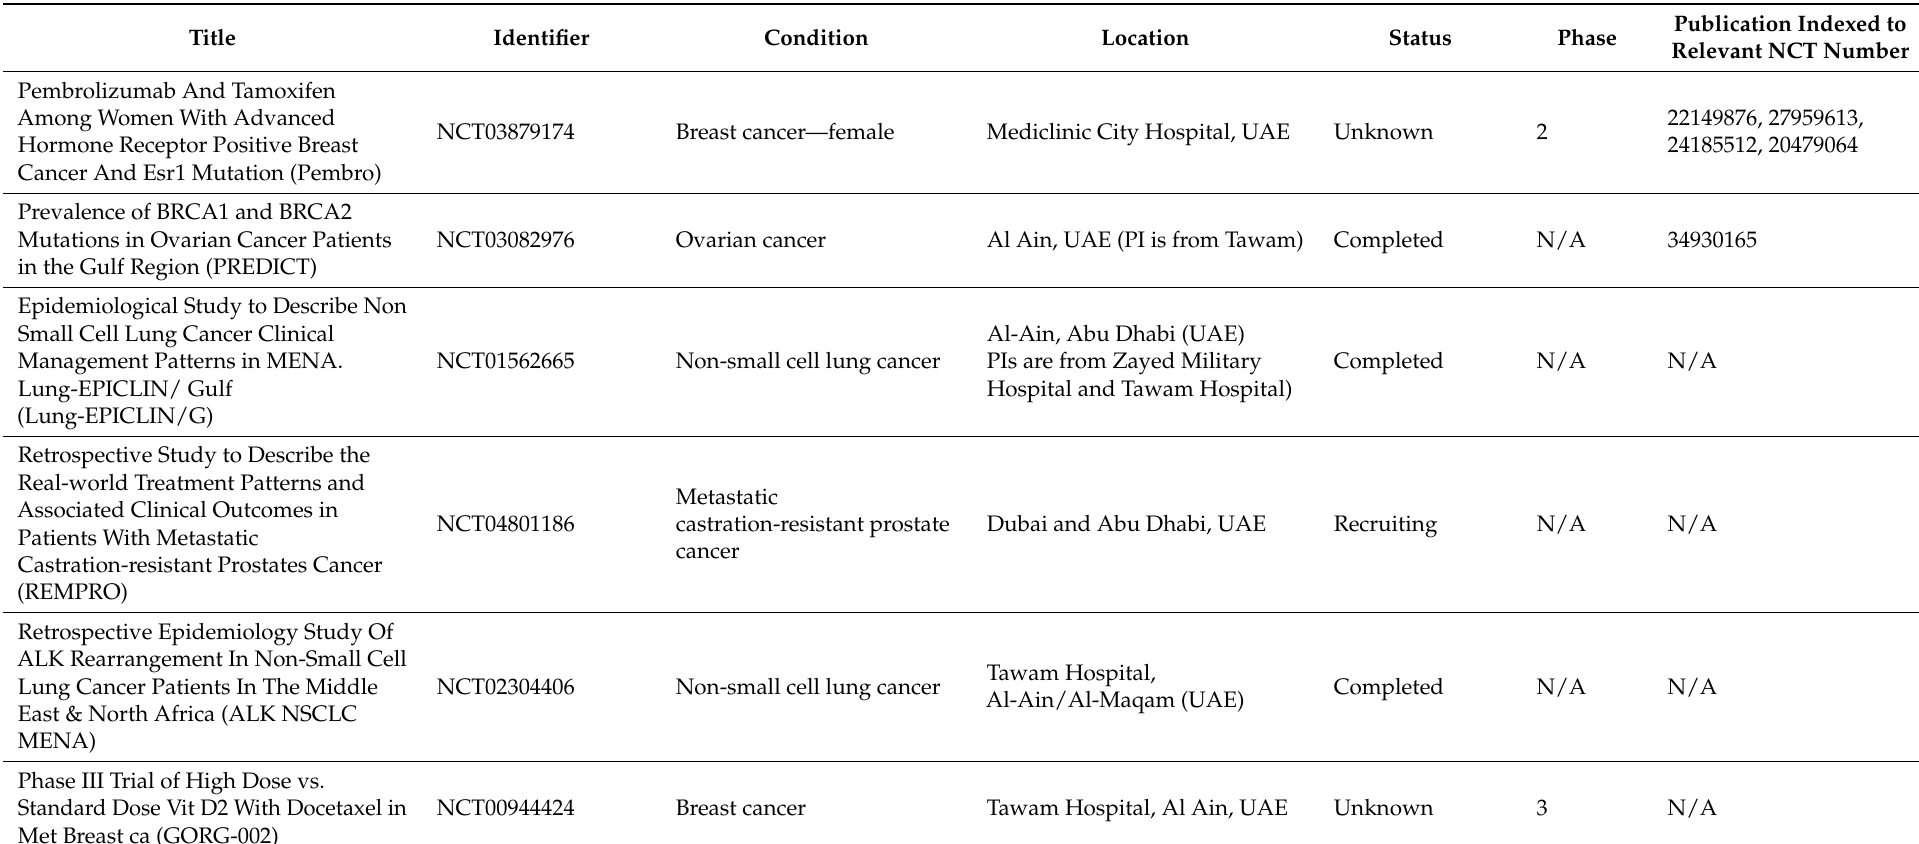
Table 2. Clinical trials in the UAE registered at clinicaltrials.gov as of October